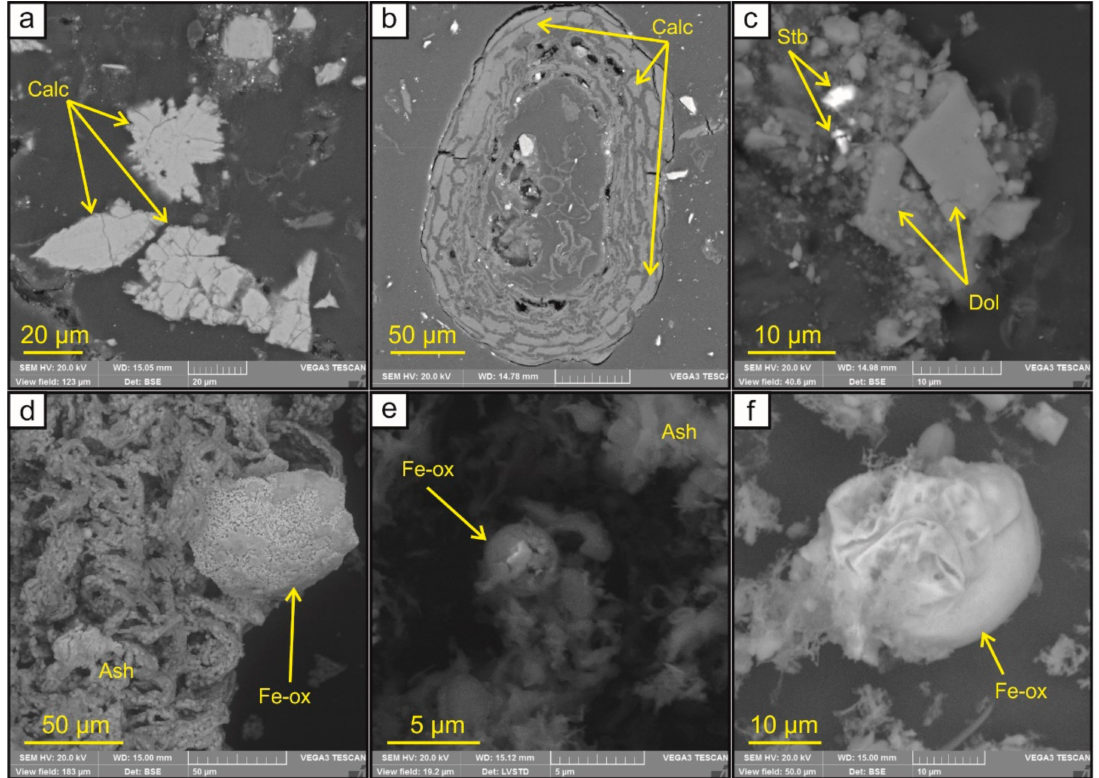
Figure 5. SEM images of carbonate and Fe-bearing (hydro-)oxides in peat: ( a ) subhedral calcite (Calc) in peat; ( b ) anhedral calcite in structure of Sphagnum tissues; ( c ) subhedral dolomite (Dol) and stibnite (Stb) in clay aggregate; ( d – f ) Fe-bearing (hydro-)oxides (Fe-ox) in ash (within oligotrophic peat sequence). The images are ( a–d,f ) backscattered and ( e ) secondary electron